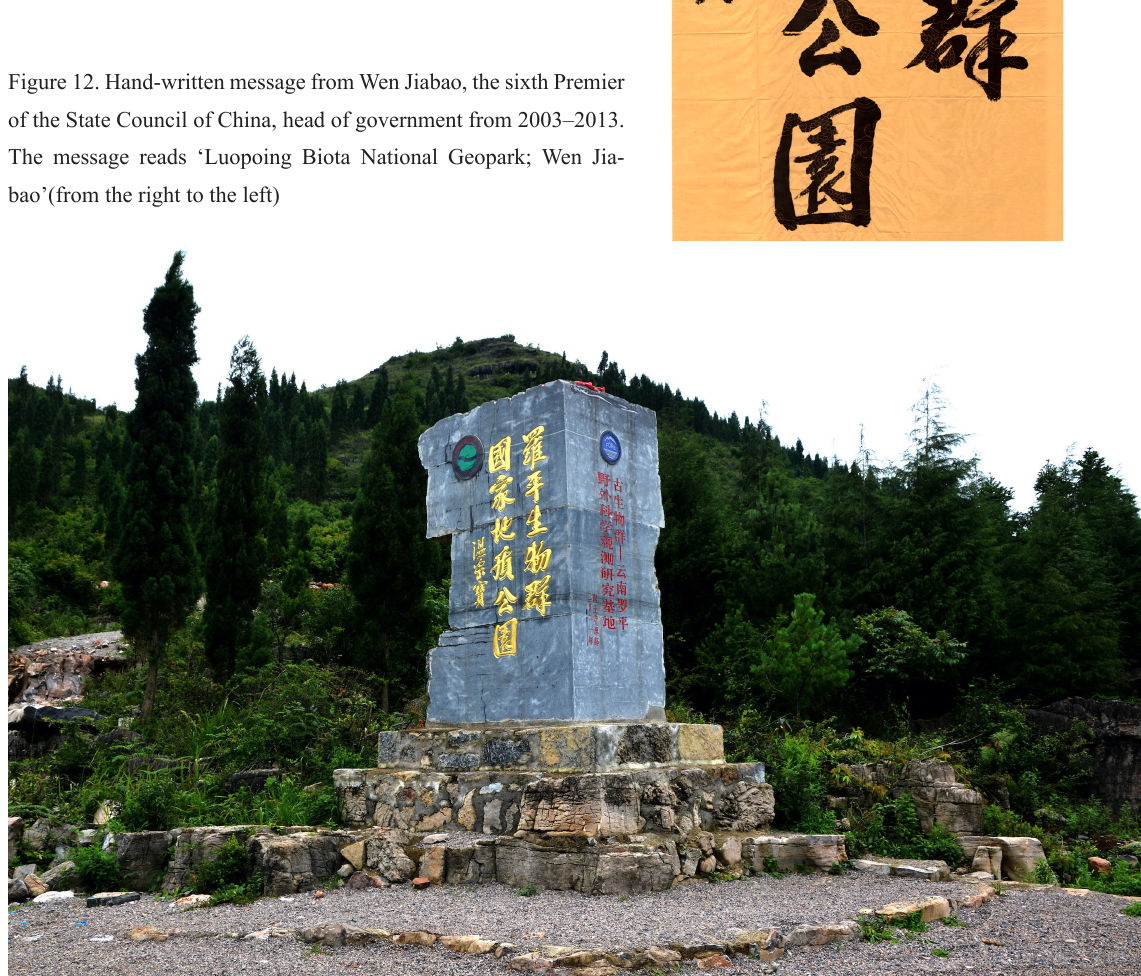
Figure 12. Hand-written message from Wen Jiabao, the sixth Premier of the State Council of China, head of government from 2003–2013.